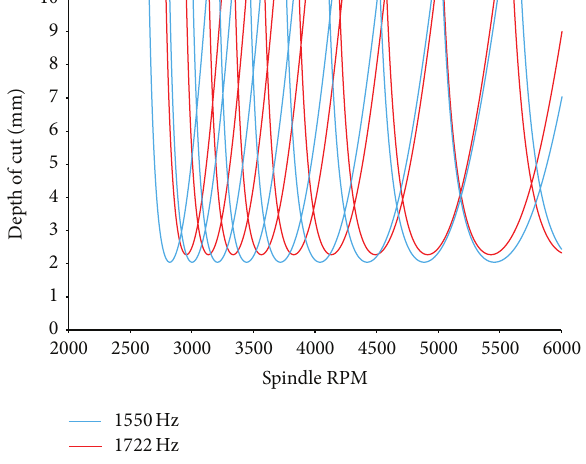
Figure 10: Stability chart an OKADA VM500 spindle using 2 different